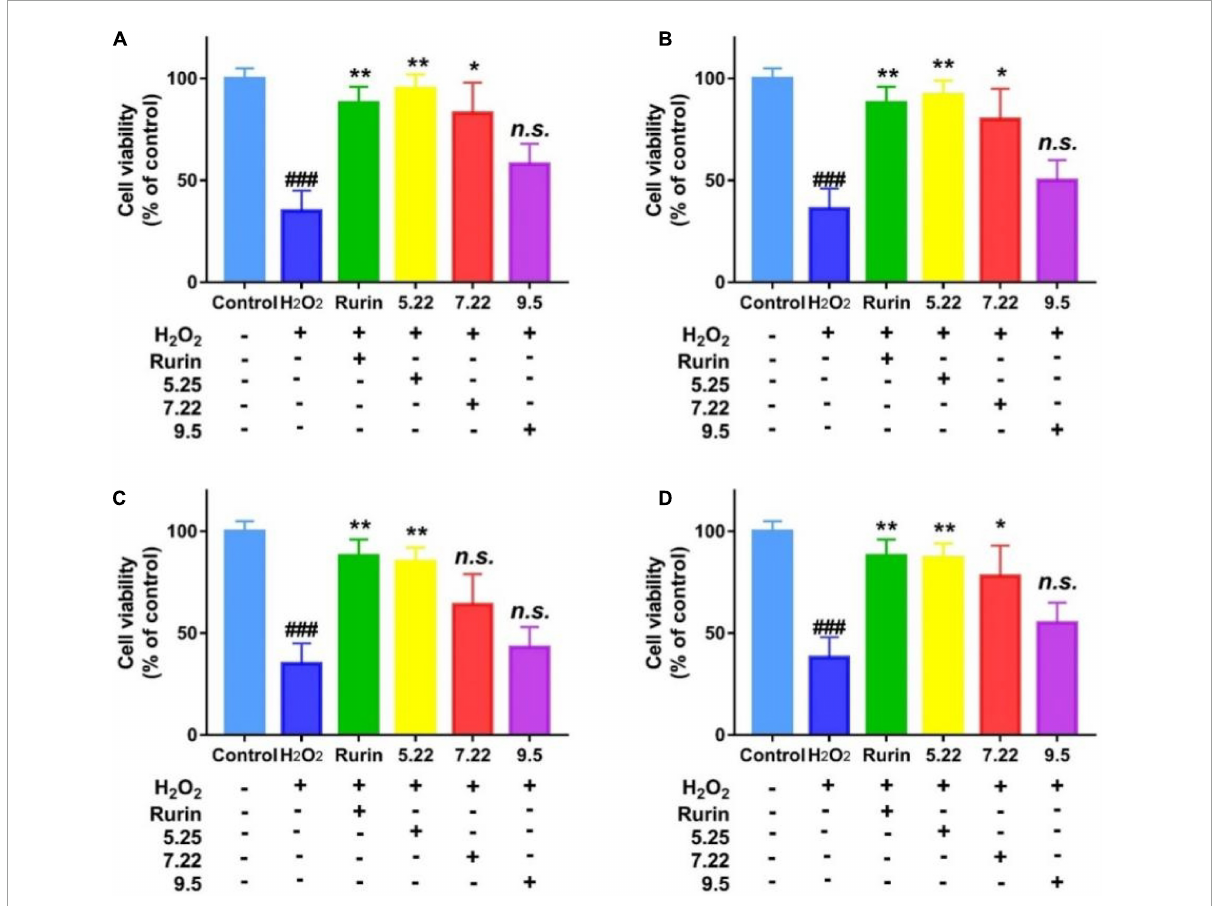
FIGURE8 Protective effects of nanguo pear (A) , Aksu Juju pear (B) , Hongxiang pear (C) and Luntai Juju pear (D) on viability losses in HEK-293 cells stimulated by hydrogen peroxide. Cells (100 µ L, 1.0 × 10 6 CFU/mL) were treated with 200 mg/mL extracts of Nanguo pear, Aksu Juju pear, Hongxiang pear and Luntai Juju pear for 0.5 h, and then incubated with hydrogen peroxide for 6 h, and then the cell viability of HEK-293 cells were measured by MTT method. All data represent means ± SD of three independent experiments. ### p < 0.001, compared with control group, ** p < 0.01 and * p < 0.05 related to H 2 O 2